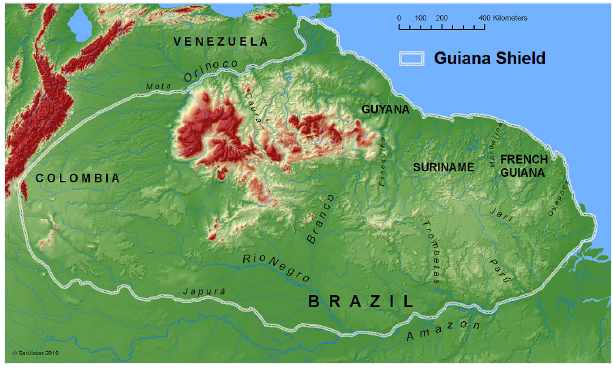
Fig. 2 . Map of the Guiana Shield, South America (kindly drawn by Sarvision